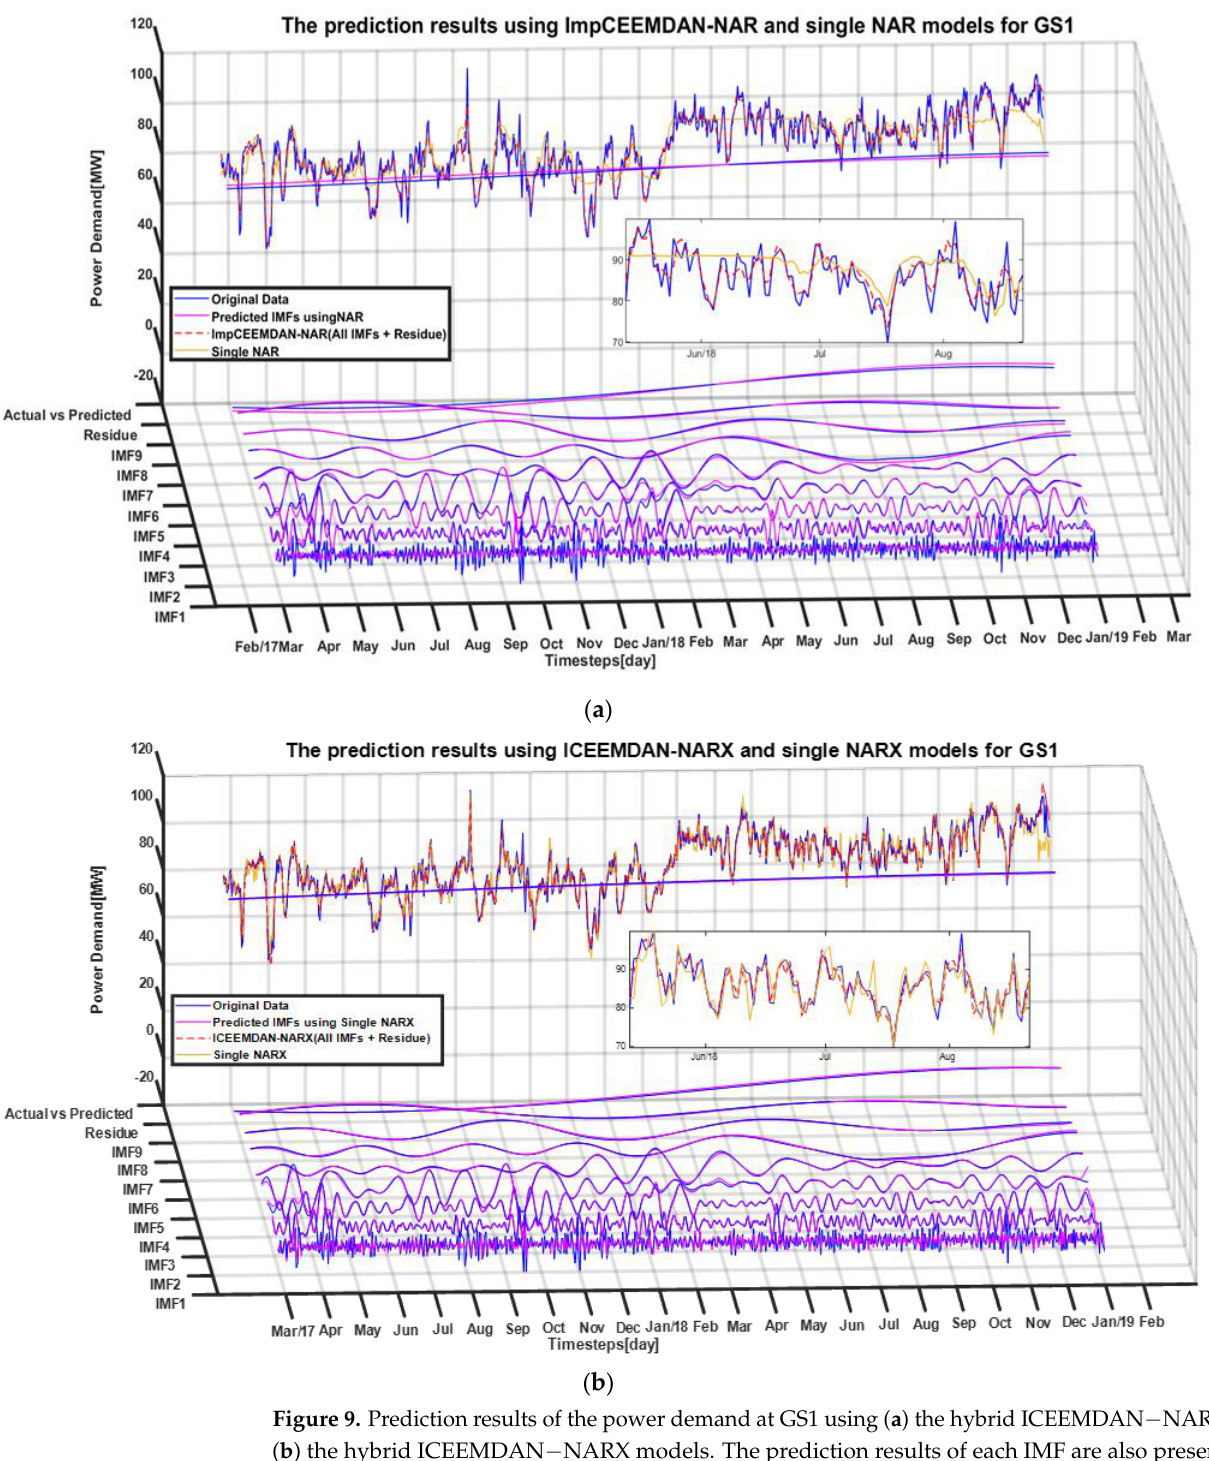
Figure 9. Prediction results of the power demand at GS1 using ( a ) the hybrid ICEEMDAN − NAR and ( b ) the hybrid ICEEMDAN − NARX models. The prediction results of each IMF are also presented, and the prediction results of the stand-alone models are shown for comparison.